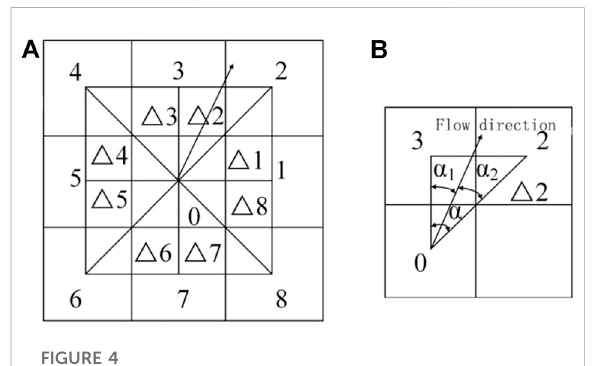
FIGURE 4 The Dinf algorithm: (A) triangle number of the Dinf algorithm and (B) fl ow direction and two downstream grid